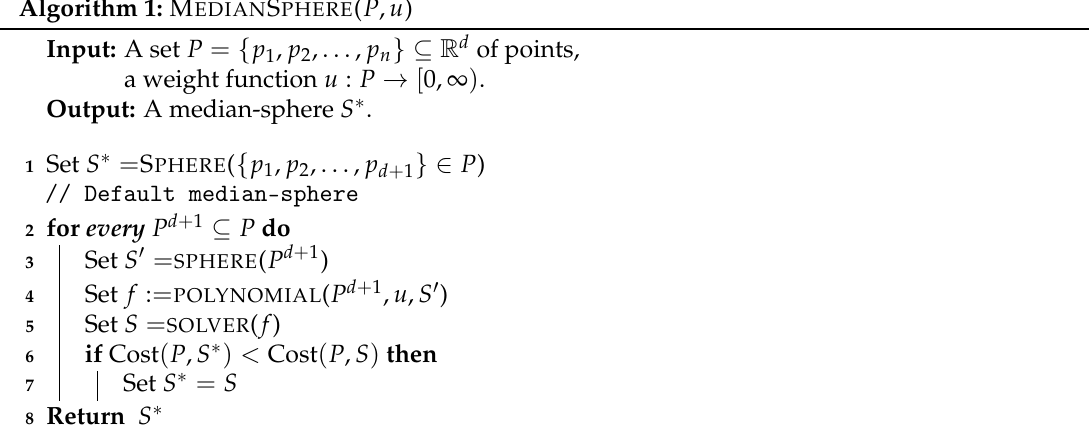
Algorithm 1: M EDIAN S PHERE ( P , u